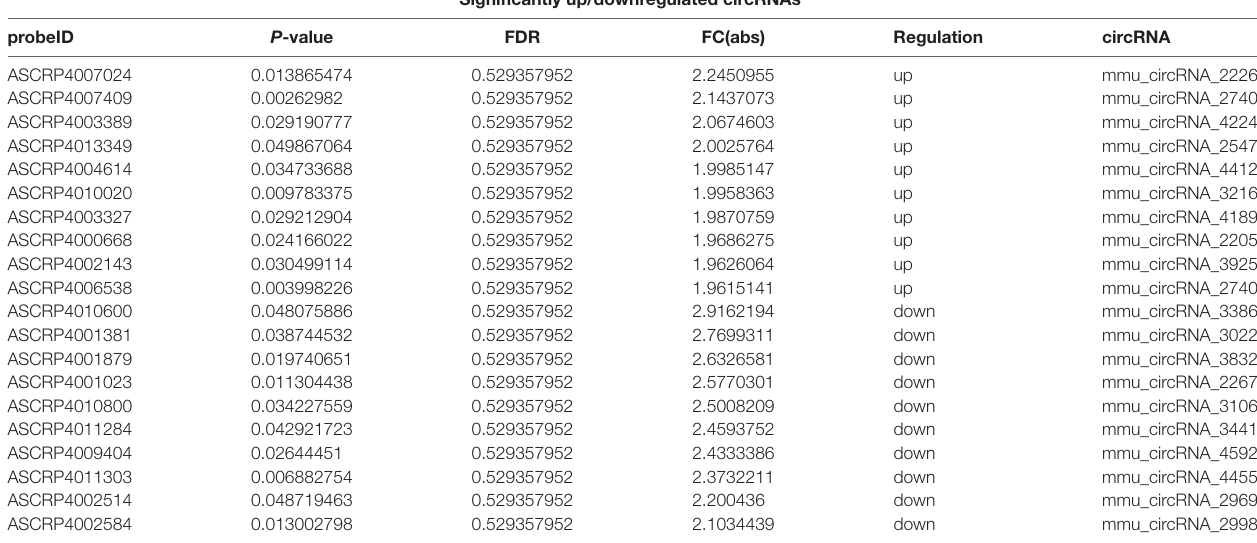
TABLE 2 | Top 10 significantly up/downregulated circRNAs in POCD of aged